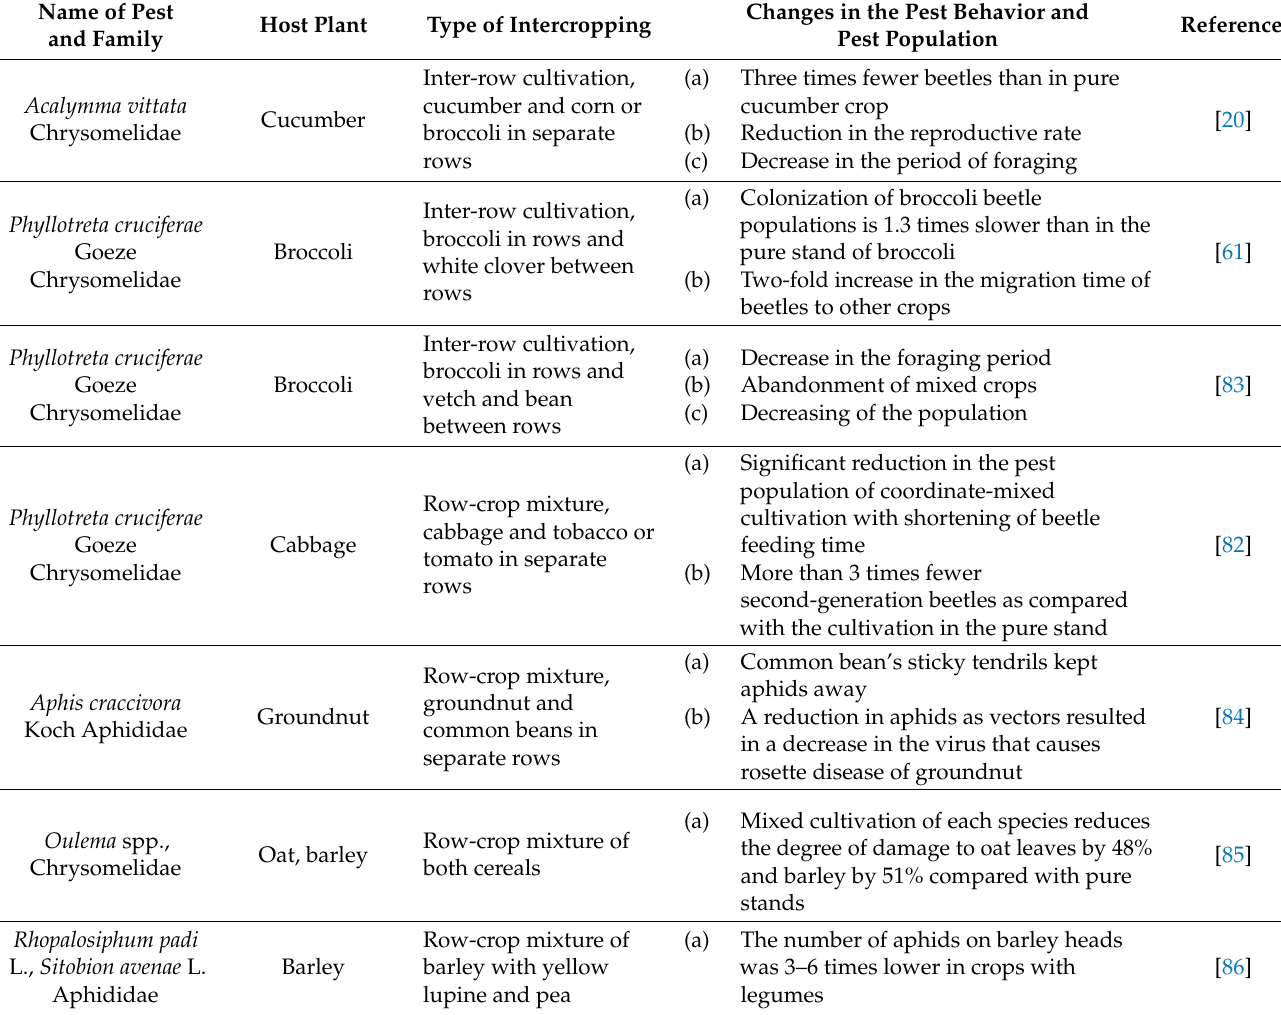
Table 1. Examples of crop pests for which changes in the behavior or development of the population have been observed due to